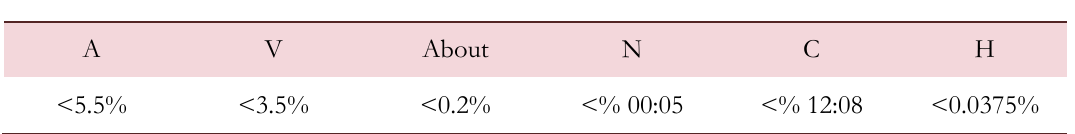
Table 1: Nominal chemical composition of the alloy Ti-6Al-4V.